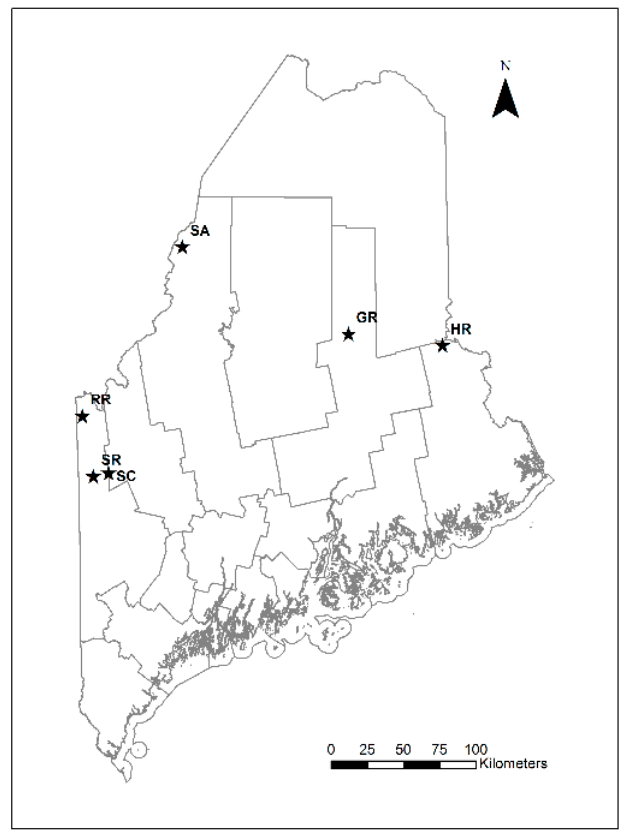
Figure 1. Study site locations in Maine with county boundaries shown. Study sites were: GR, Golden Road; HR, Harlow Road; RR, Rump Road; SA, St. Aurelie; SC, Schoolbus Road; SR, Sarah’s